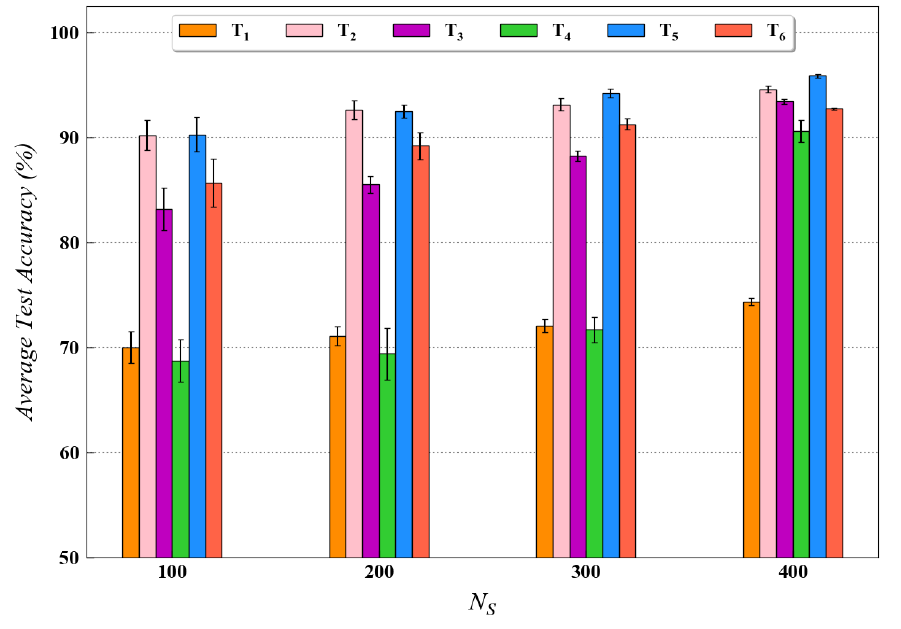
Figure 10. Performance analysis results for various transfer tasks of Paderborn dataset with different training data size using the proposed